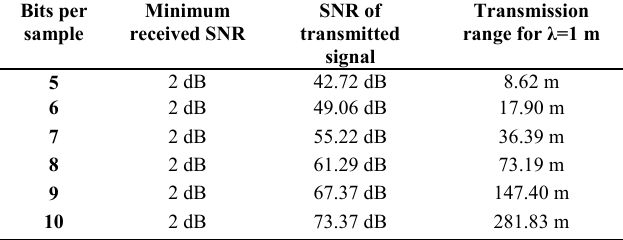
Table 3: The transmission range for λ = 1 meter.